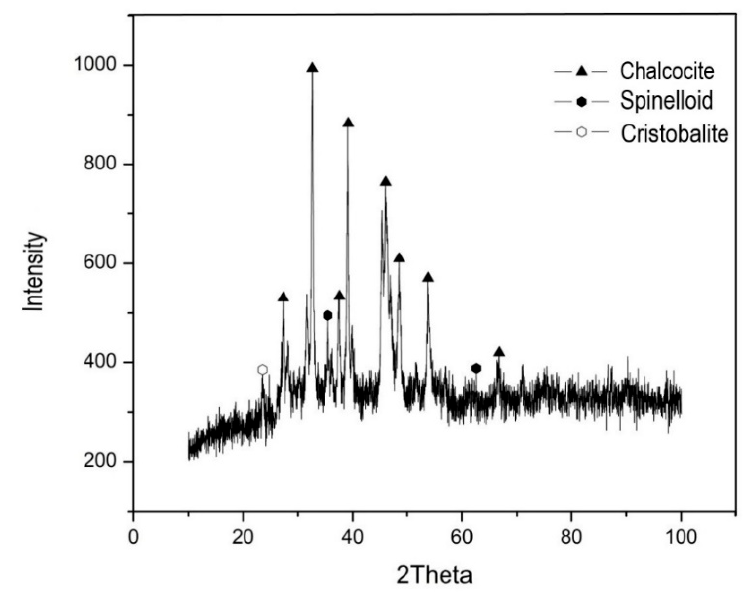
Figure 1. White metal diffractogram.